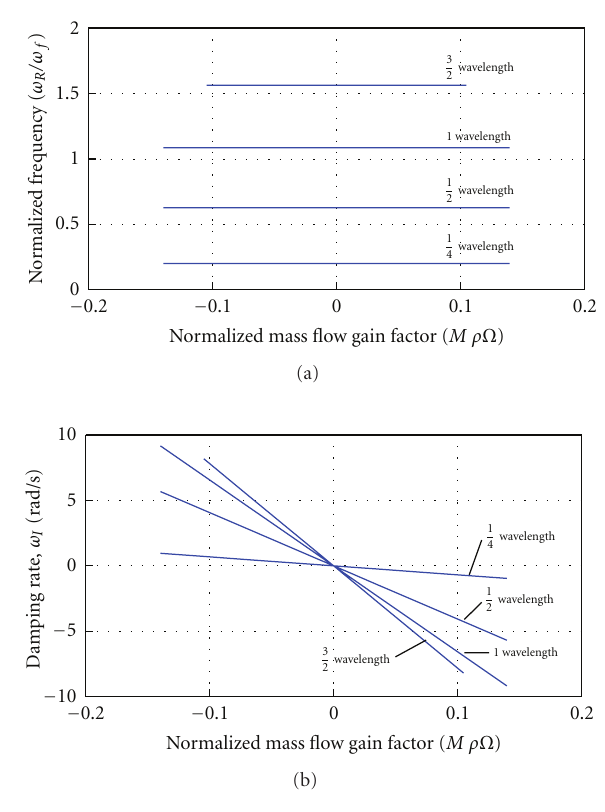
Figure 6: (a) Analytical results of real part, ω R , showing trend anal- yses on ( M ( K/ ( R/ρ Ω 2 ) = 0 . 14, K drag = 0.) (b) Analytical results of imaginary part, ω I , showing trend analyses on ( M ( K/ ( R/ρ Ω 2 ) = 0 . 14 , K drag = 0).